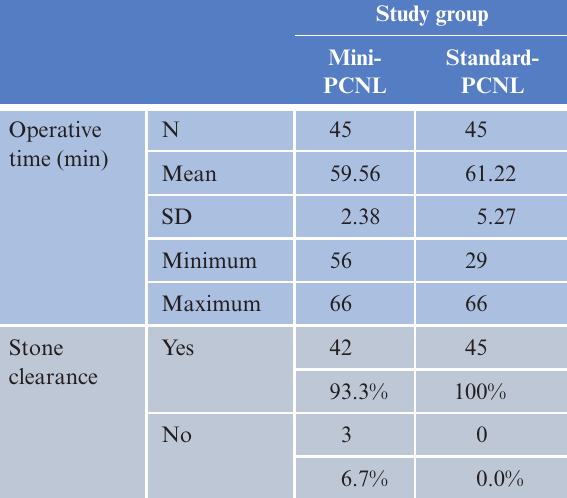
Table 2: Comparison of operative time and stone clearance in both